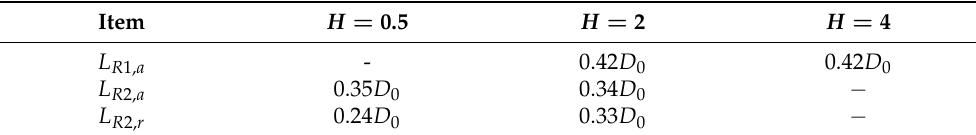
Figure 9. Radial skin friction on the target surface for the straight nozzle. Table 2. Size of the recirculation for the straight